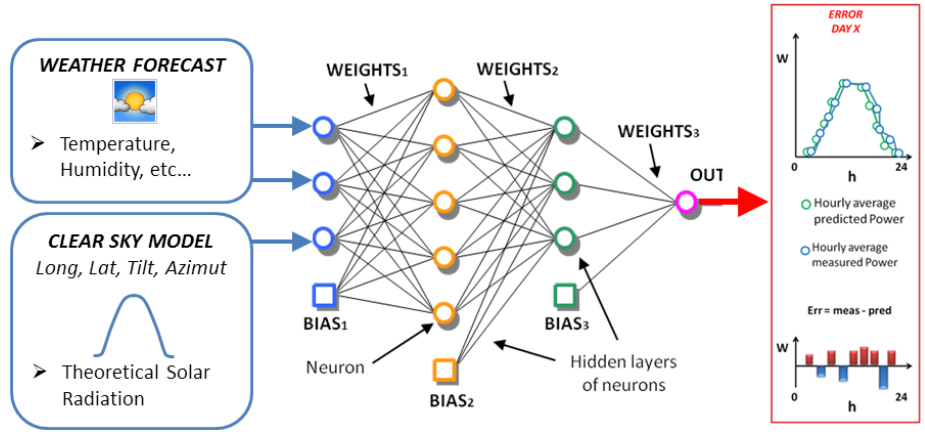
Figure 2. Physical Hybrid Artificial Neural Network (PHANN) method schematic diagram.